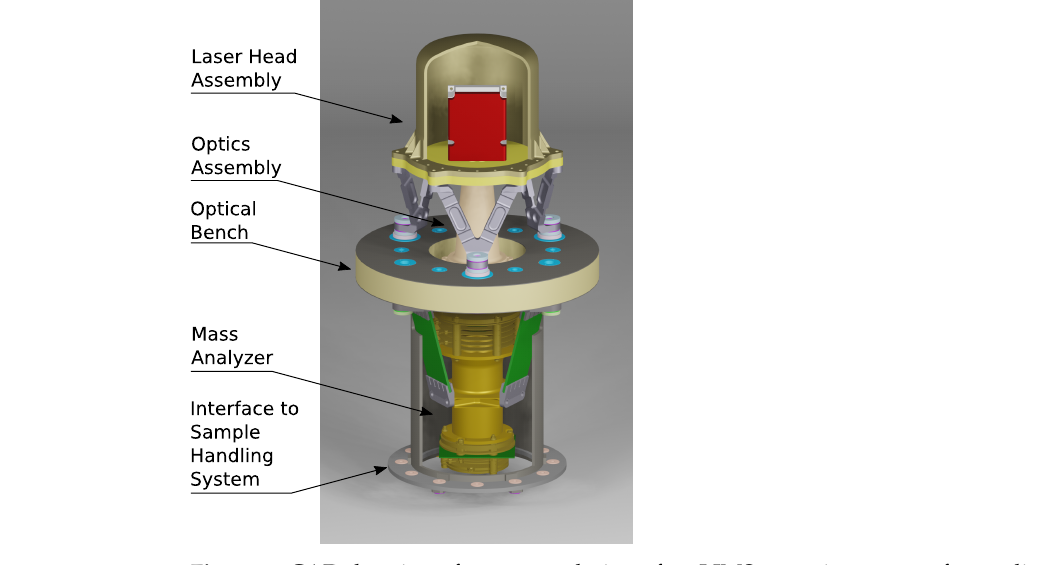
Figure 5. CAD drawing of a concept design of an LIMS space instrument for studies of the lunar surface. A design similar to this can also be used for an ORIGIN instrument on the VLF mission.